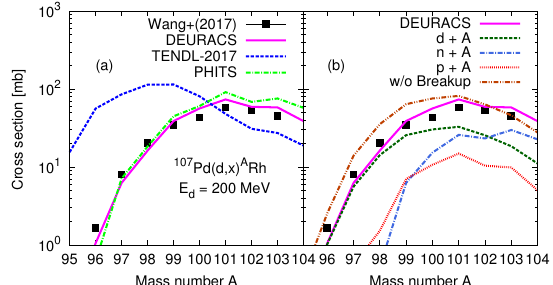
Figure 1. Calculated and experimental DDXs for the ( d , xn ) re- action on natural lithium at 200 MeV. Comparison of the DEU- RACS calculation with the experimental and other calculated data is presented in (a), and the components corresponding to each reaction process in the DEURACS calculation are shown in (b). Open squares are the experimental data taken from Ref. [19]. Figure 4. Calculated and experimental cross sections for the Figure 2. Same as figure 1 but for the 27 Al( d , xt ) reaction at 80 27 Al( d , x ) 22 Na reaction. Comparison of the DEURACS calcula- MeV. Experimental data are taken from Ref. [26]. tion with the experimental and other calculated data is presented in (a). The contributions from the absorption of deuteron, pro- ton, and neutron in DEURACS are shown in (b). The calculated result with DEURACS in which the breakup processes are not considered is also shown in (b). Experimental data are taken from Refs. [27–29]. See text for the meaning of the curves.